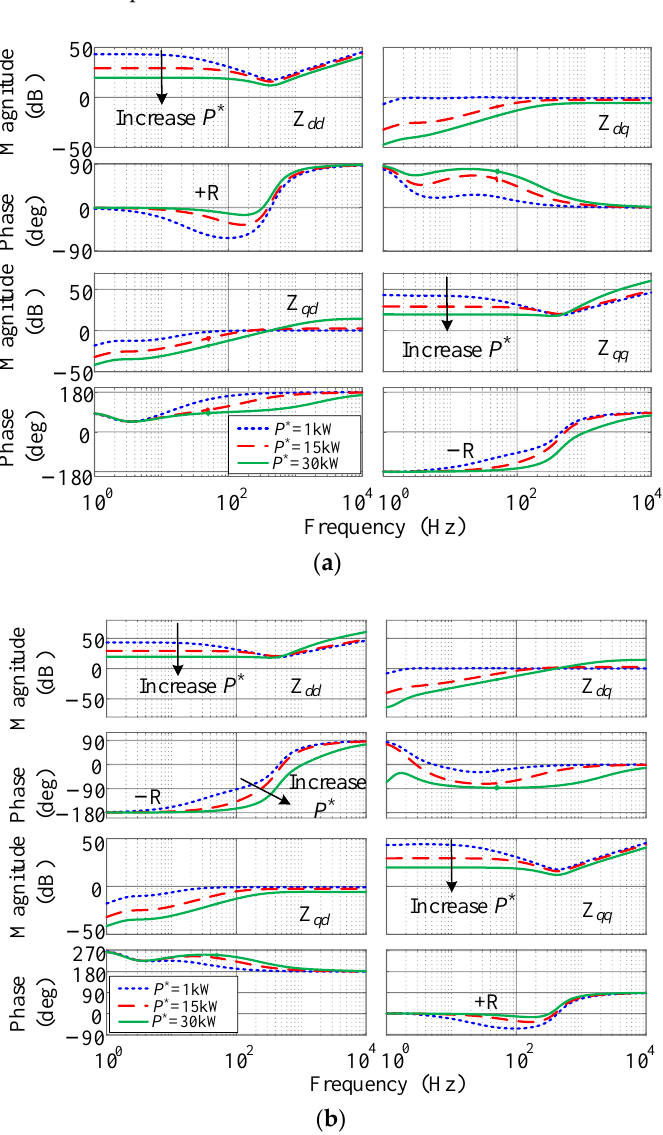
Figure 5. Bode plots of converter output and input impedance as power increases. ( a ) Output impedance under forward power flow; ( b ) input impedance under reverse power flow.